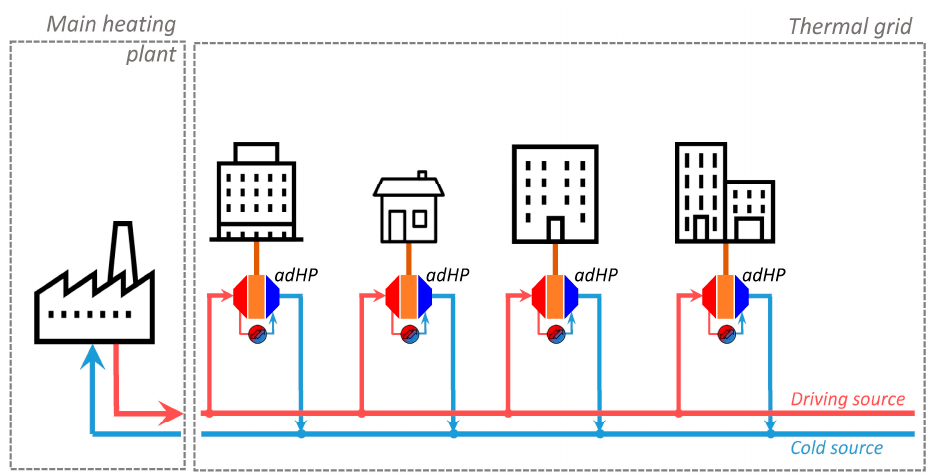
Figure 5. Schematic representation of Scenario 2. Figure 6. Schematic representation of Scenario